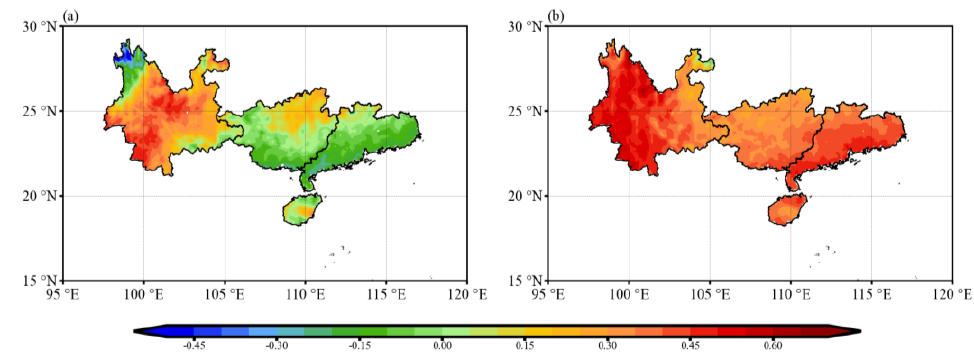
Figure 8. The distribution of the Pearson correlation of the AWDp (precipitation – potential evapo- ration) and the SWDI ( a ) and the AWDt (precipitation – total evaporation) and the SWDI ( b ) in the four southern provinces of